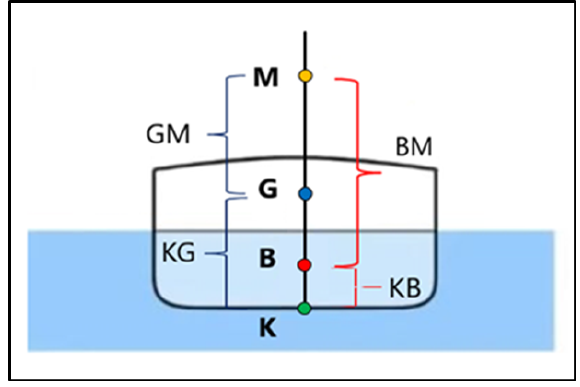
Figure 6. Metacentric